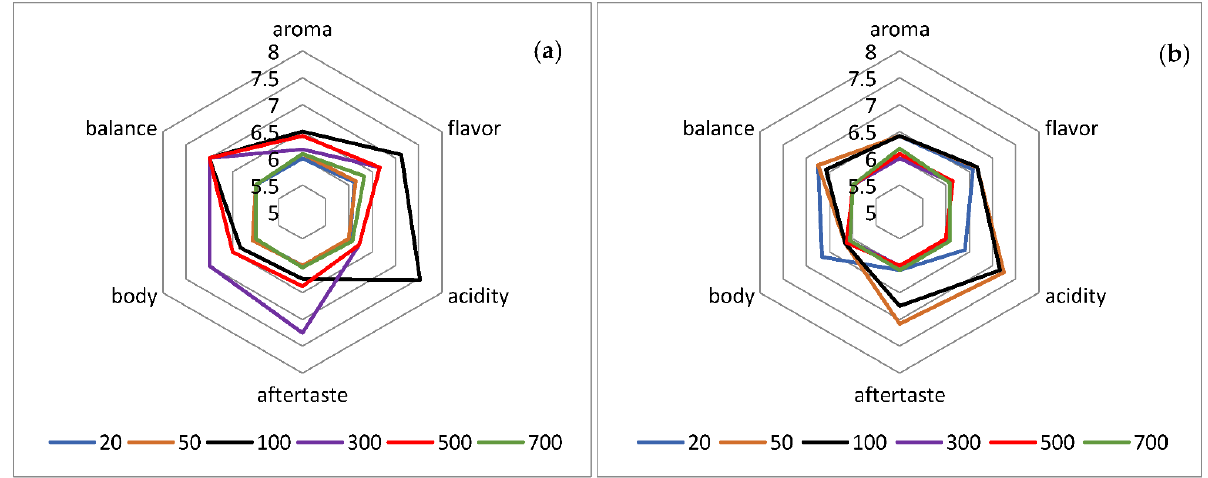
Figure 3. Sensory analysis of extraction under reduced pressure (variation of pressure) ( a ) for 2 vacuum cycles; ( b ) for 7 vacuum cycles.